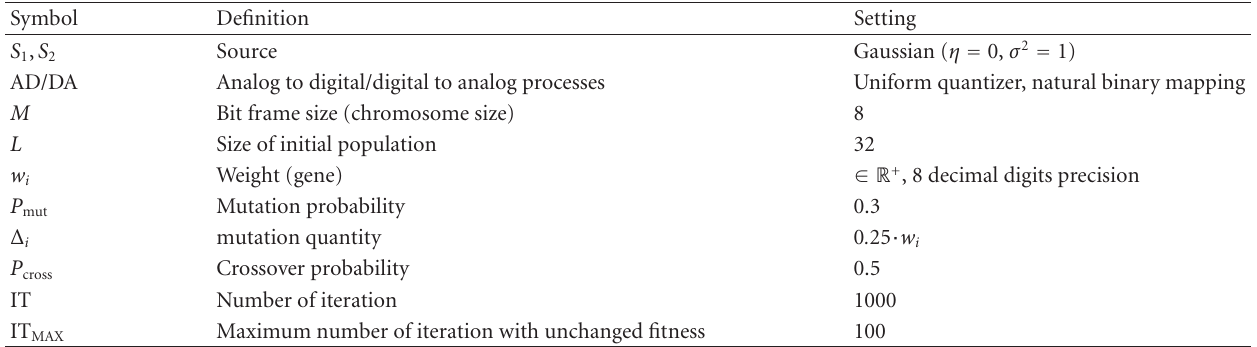
Table 1: Parameters setting for experiments.